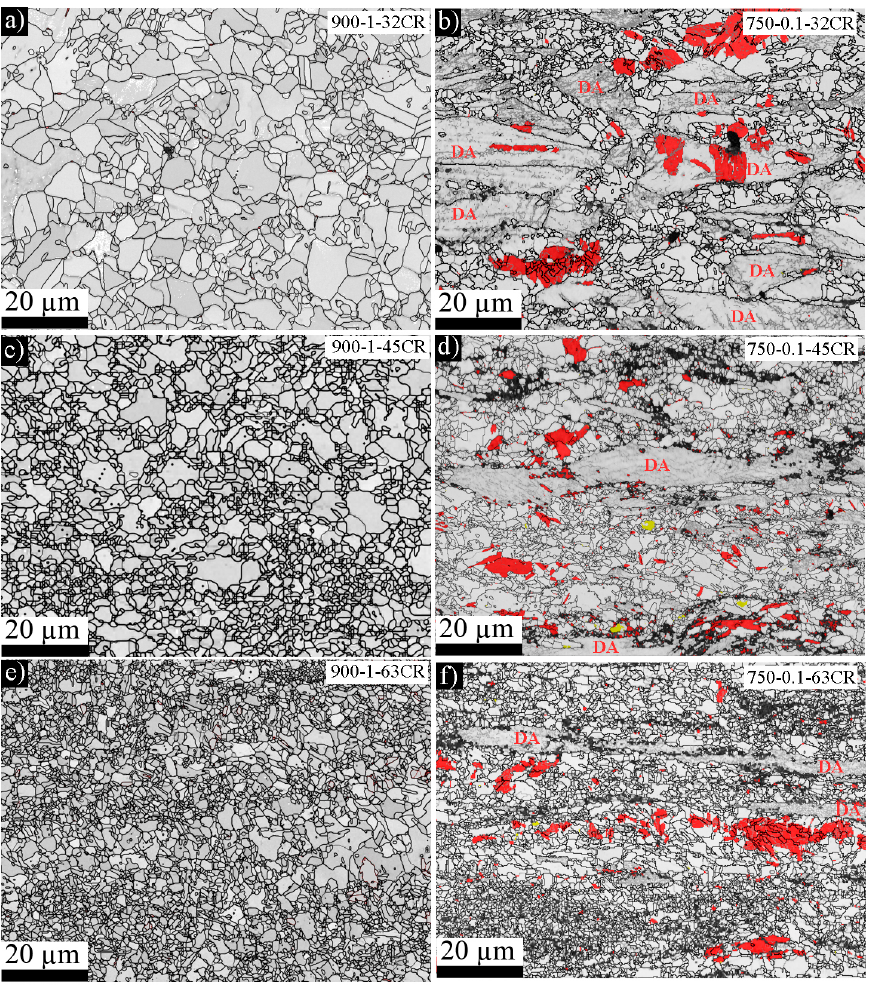
Figure 2. Initial structures (electron backscatter diffraction (EBSD) image; cross-sectional view near the surface) ( a ) 900-1-32CR, ( b ) 750-0.1-32CR, ( c ) 900-1-45CR, ( d ) 750-0.1-45CR, ( e ) 900-1-63CR, ( f ) 750-0.1-63CR revealing differences in the grain size and phase structures after different cold rolling (CR) reductions. Retained DIM as red and epsilon martensite in yellow in ( b , d , f ). Retained deformed austenite is marked as deformed austenite (DA).